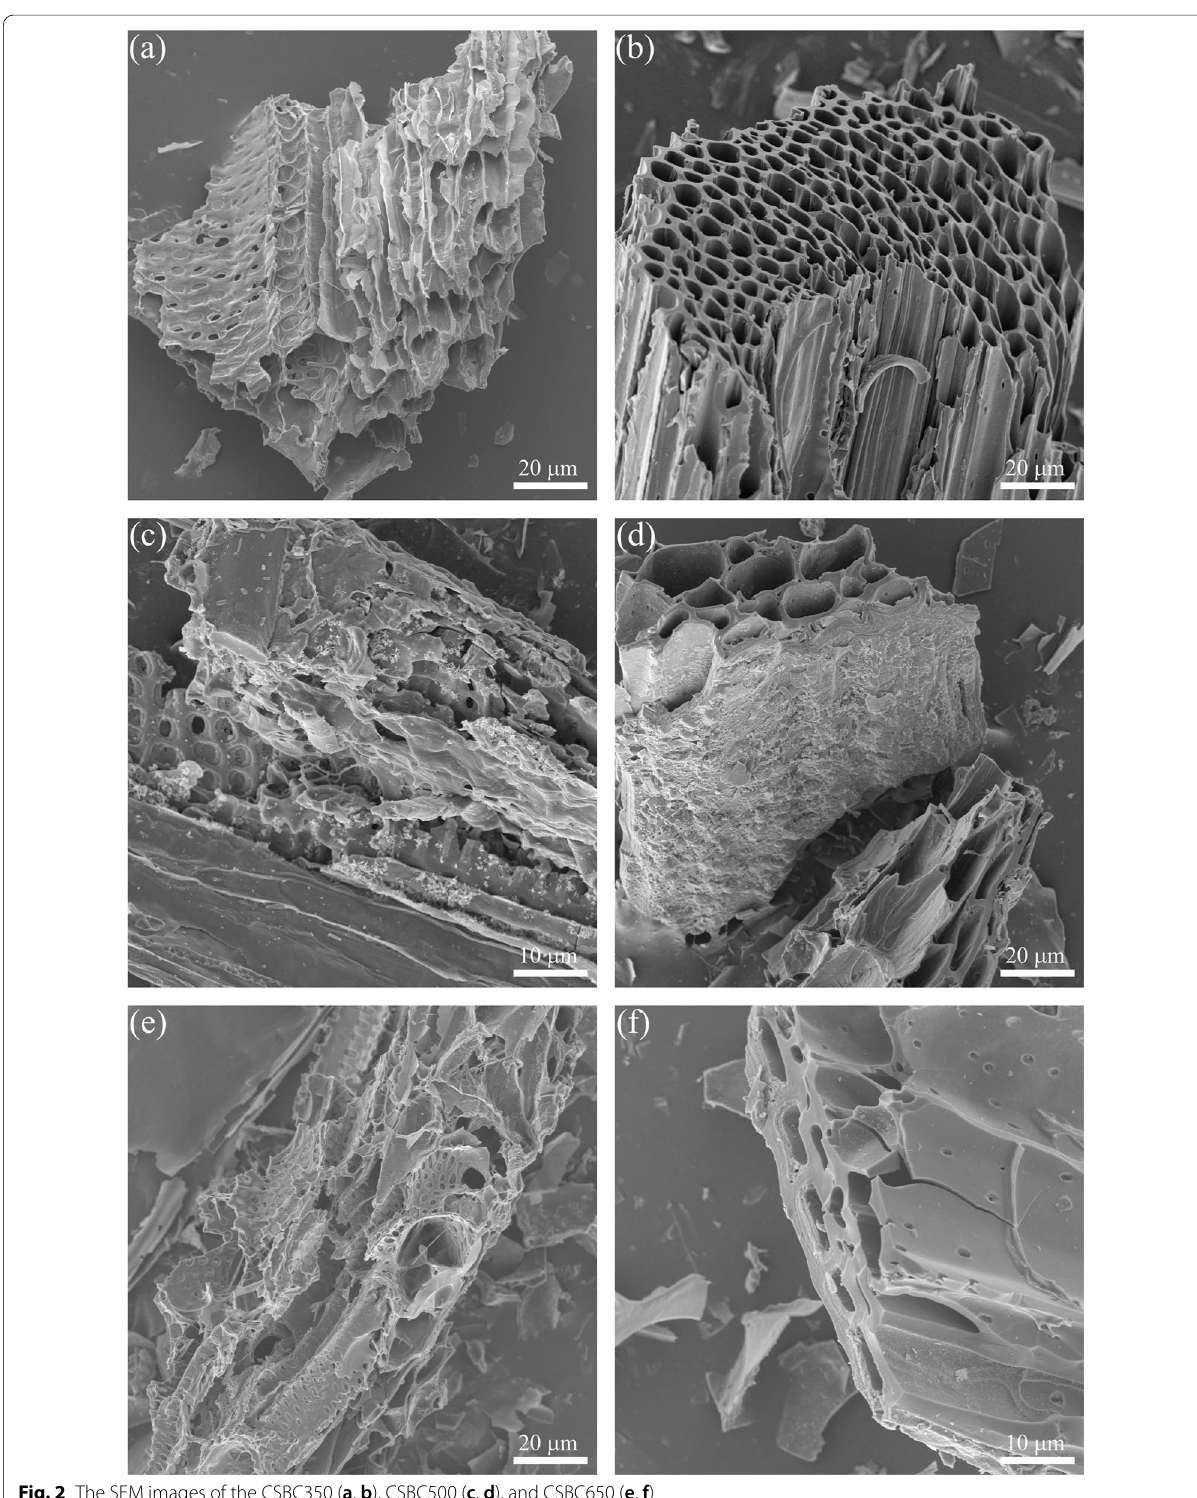
Fig. 2 The SEM images of the CSBC350 ( a , b ), CSBC500 ( c , d ), and CSBC650 ( e , f